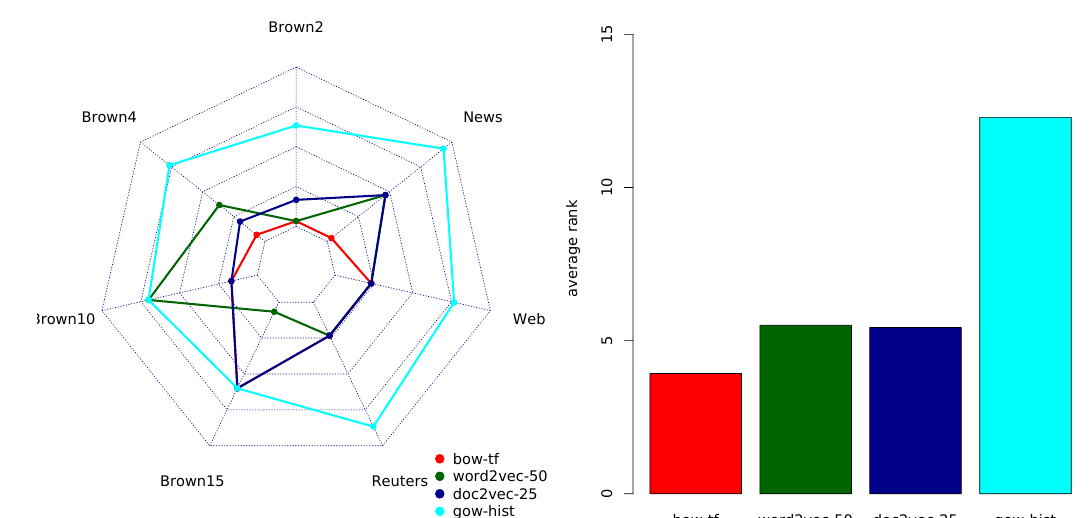
Figure A1. Radar-chart comparison of the multi-objective rankings by task ( left ) and their averages ( right ) for the four top-performing variants of the document representation models in each of the four groups with respect to precision.